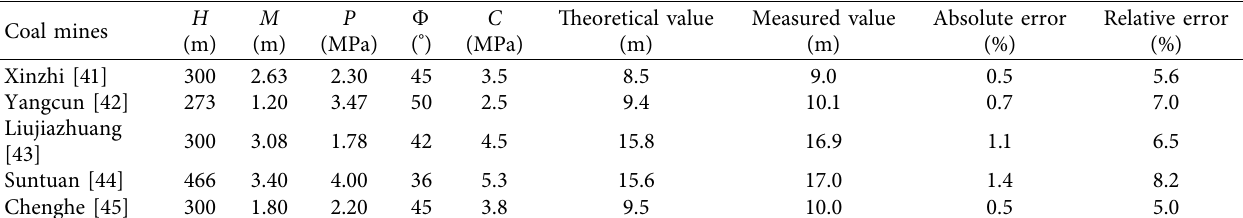
Figure 11: The results of measured water leakage in boreholes. (a) No. 1 borehole (before mining). (b) No. 2 borehole (after mining). (c) No. 3 borehole (after mining). Table 1: Analysis of measured values and theoretical values of floor failure depth in five coal